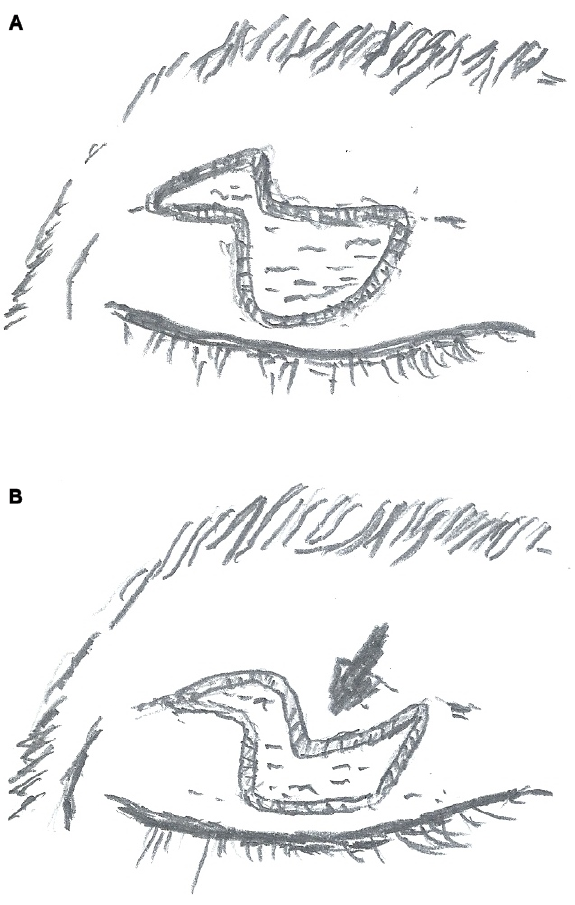
Figure 3: A) An advancement flap was fashioned. B) An advancement flap of the skin and orbicularis of the upper eyelid was undermined, elevated, and advanced inferiorly over the defect.